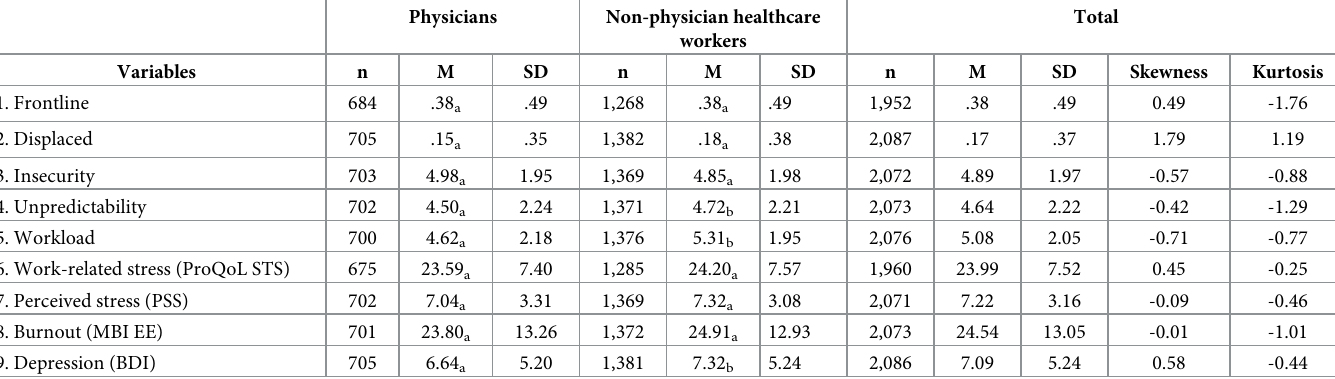
Table 1. Comparative descriptive statistics of the study variables between physicians and non-physician HCWs.